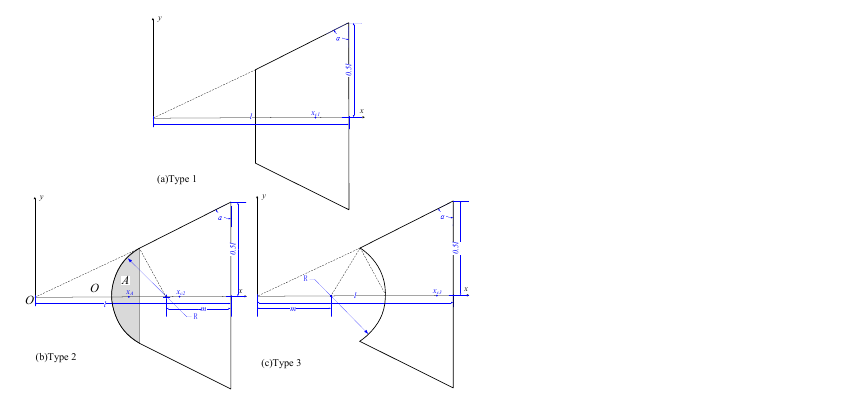
Figure 4. Rails’ coordinate system and dimensions. ( a ) Flat rail; ( b ) convex rail, ( c ) concave rail.